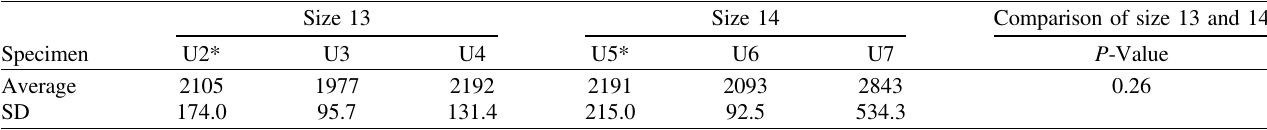
Table 1. The average stiffness and standard deviation for each specimen is shown. Each specimen underwent six repeat tests. The asterisk (*) indicates the specimen used for strain